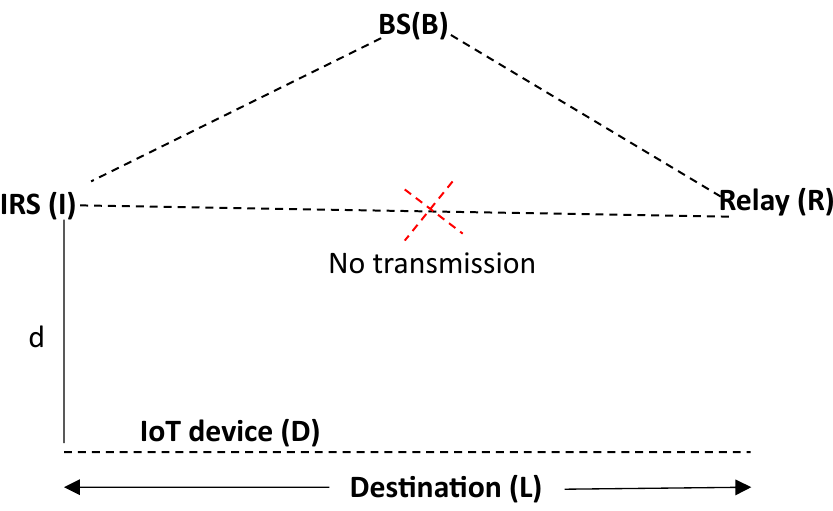
Figure 2. The simulation setup by varying distance L.